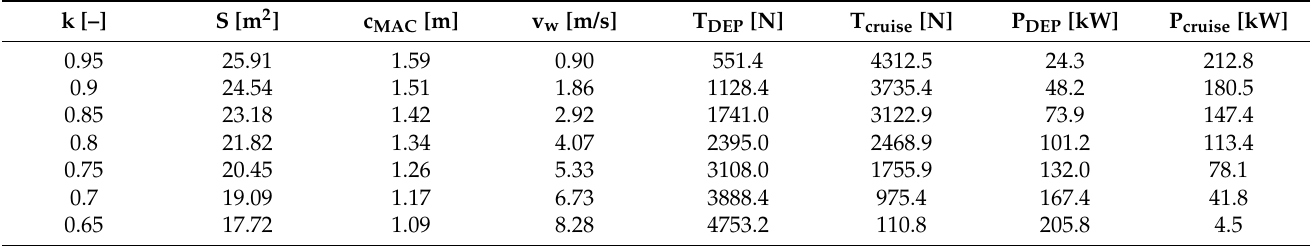
Table 2. Results of DEP sizing for twenty propellers, geometrical and power variables.